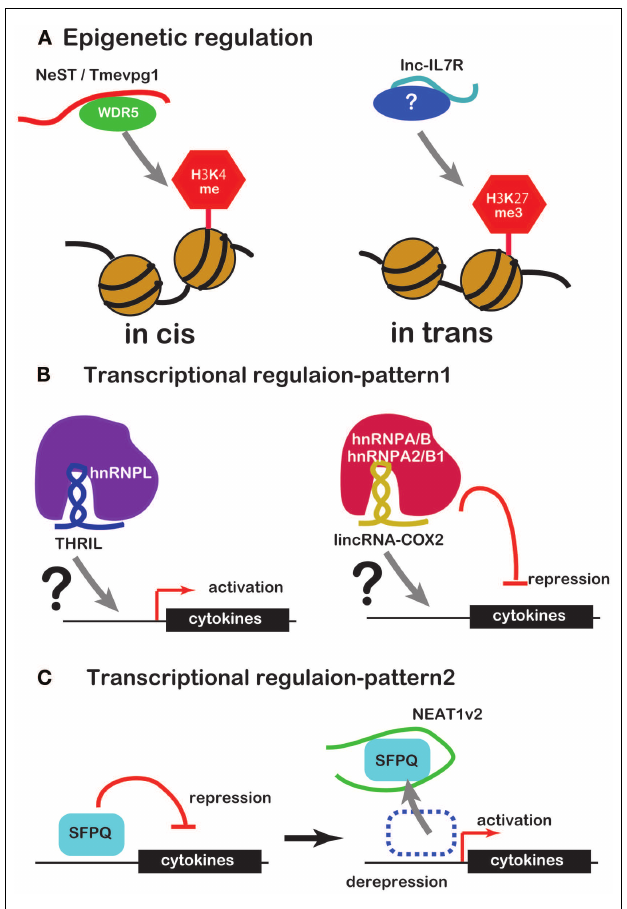
FIGURE 1 | ncRNAs that regulate chromatin structure and transcription factors. (A) NeST/Tmevpg1 activates transcription of genes by recruiting the histone modifierWDR5, which methylates H3K4. Lnc-IL7R activates transcription of genes by H3K27 trimethylation. (B) The complex ofTHRIL and hnRNPL activates transcription of genes.The complex of lincRNA-Cox2 and hnRNPA/B or hnRNPA2/B1 represses transcription of genes. (C) NEAT1 activates transcription of genes by sequestration of transcriptional factor